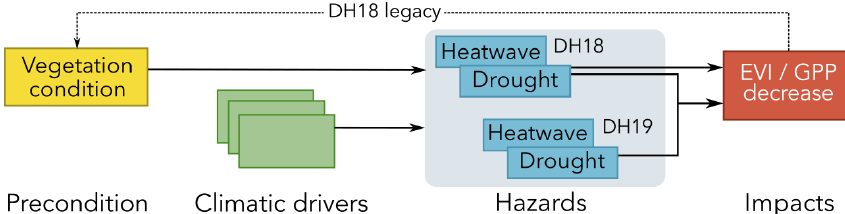
Figure 1. Conceptual description of the compound DH18 and DH19 events. Dry and hot conditions in both summers were a result of compounding atmospheric drivers (synoptic patterns, preceding climate anomalies, land–atmosphere interactions). The DH18 impacts were preconditioned by seasonal legacy effects in ecosystem functioning from a sunny and warm spring. We hypothesise that legacies from the DH18 event also acted as a precondition of the response to DH19. Further modulating effects (not shown) include impacts of anthropogenic climate change on drivers, hazards, vegetation conditions, and land cover in modulating responses to